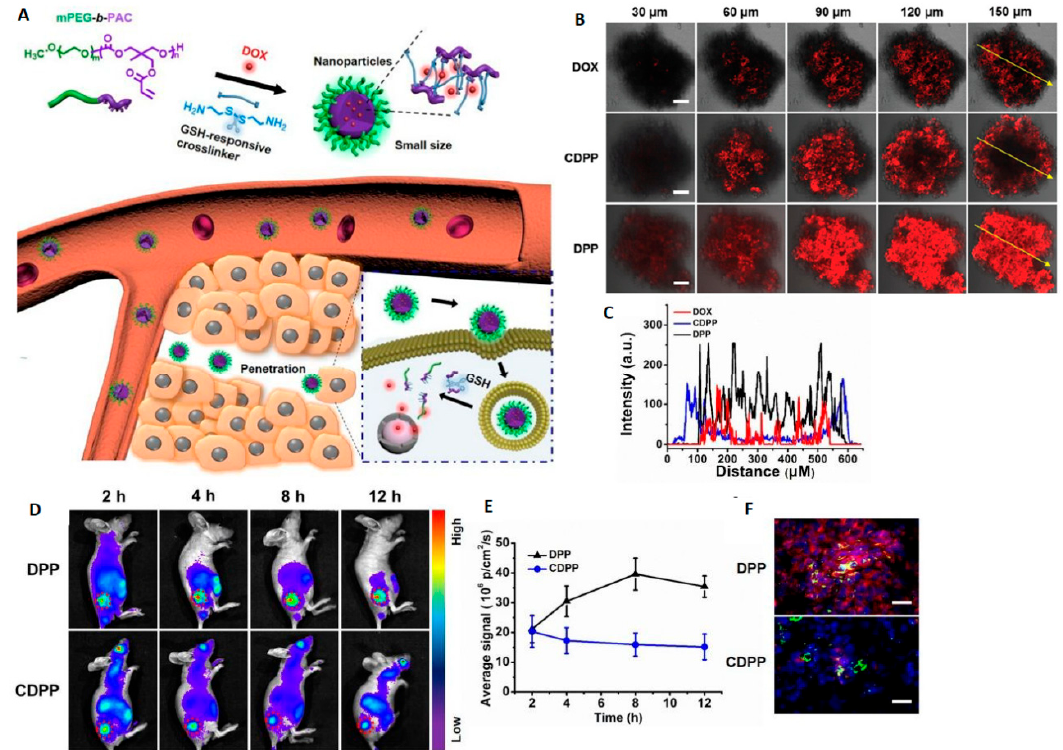
Figure 6. ( A ) Schematic illustration of small-sized crosslinked copolymeric nanoparticles for deep tumor penetration and intracellular reduction-triggered drug release. ( B ) Confocal laser scanning microscopy (CLSM) images of multicellular tumor spheroids treated with DOX, micelles with average size ~50 nm (CDPP), and small-sized micelles with average size ~19 nm (DPP). Scale bar represents 100 μ m. ( C ) Semiquantitative fluorescence along the line drawn on the central slice in all groups. ( D ) In vivo fluorescence imaging of tumor-bearing mice after injection of Cy-5 labeled DPP and CDPP. The red circles indicate the tumor sites. ( E ) Quantitative fluorescence analysis in the tumor at different times. ( F ) Frozen sections of HeLa tumors after treatment with CDPP or DPP. The tumor vessels and nuclei are stained with FITC-tagged CD31 antibody (green) and DAPI (blue), respectively. Scale bar represents 50 μ m. Reprinted with permission from ref [129]. Copyright 2020 Royal Society of Chemistry.